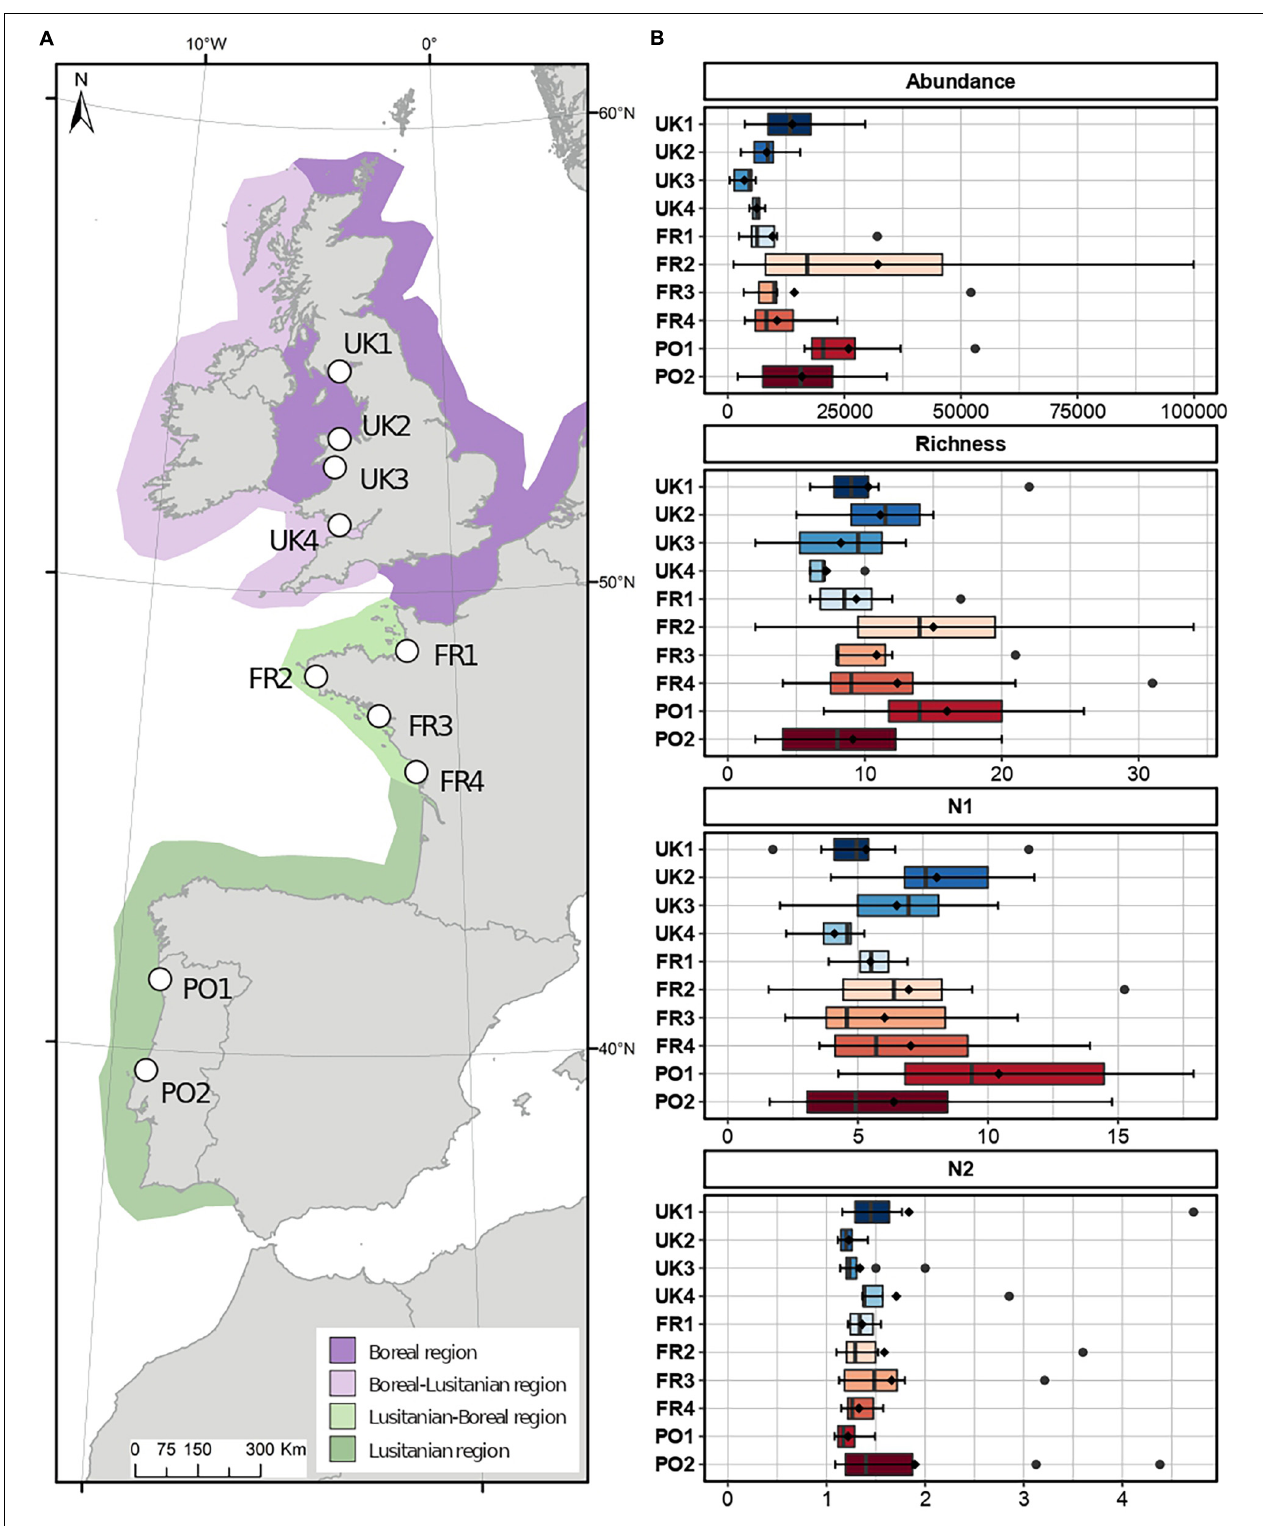
FIGURE 1 | (A) Map indicating the locations of the 10 study sites in the United Kingdom, France, and Portugal within the four biogeographic provinces defined by Dinter (2001). (Eight stations were sampled in each of the ten sites, except for UK4 where five stations were sampled.) (B) Abundance ( ± SD) of the associated macrofauna (in number of individuals.m − 2 ) and taxonomic indices (Richness, Hill diversity indices N1 and N2) per site.